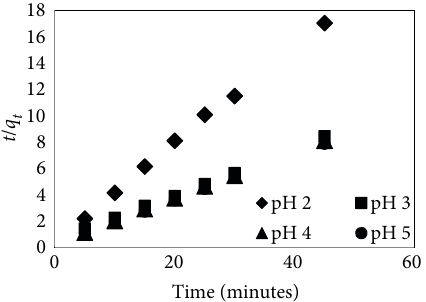
Fig. 9. Graphs of pseudo second-order kinetic models for biosorption of Cu 2+ ions onto tobacco